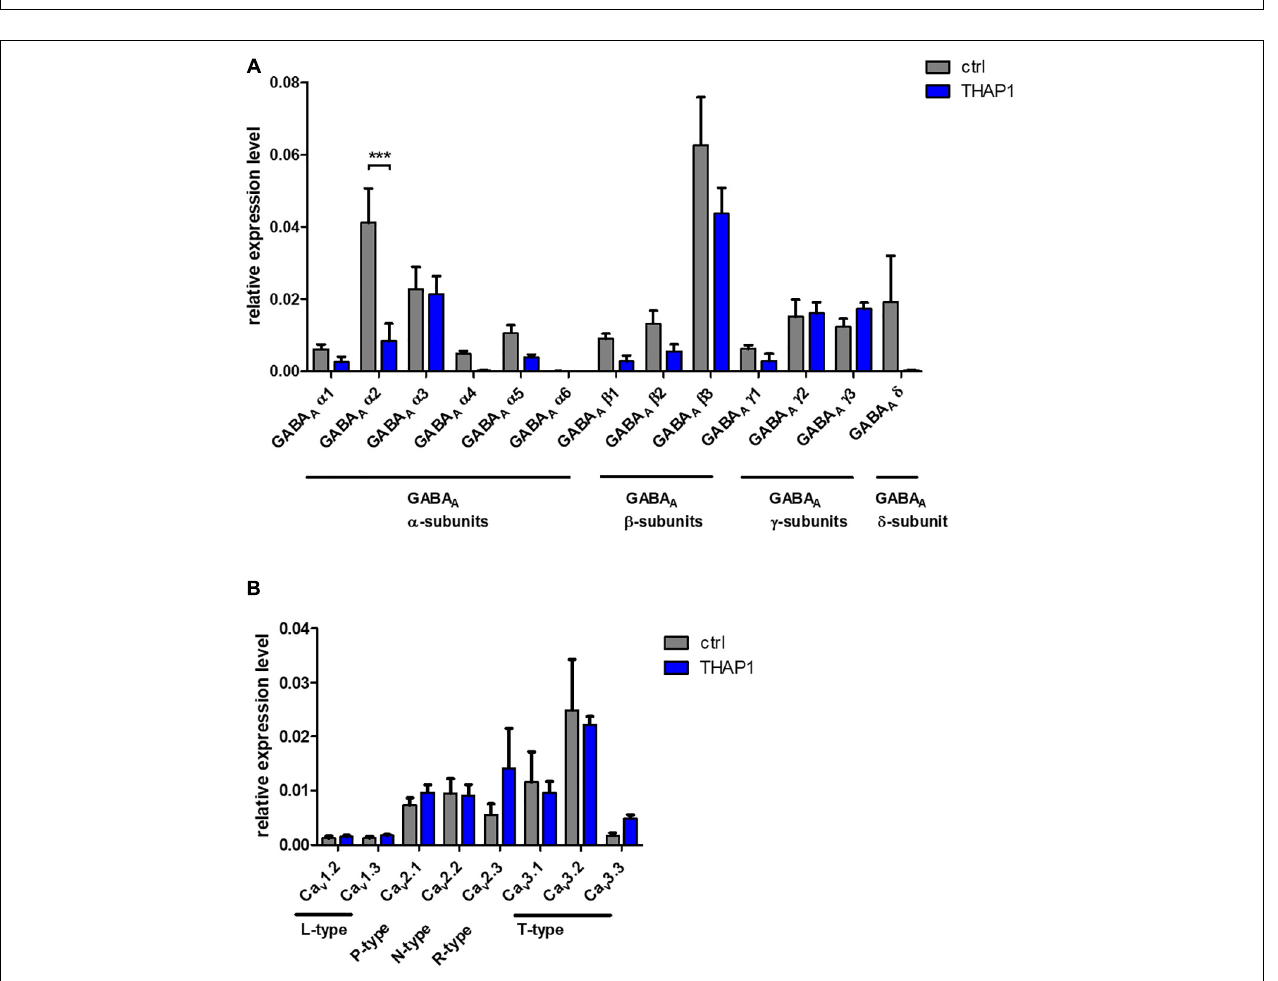
FIGURE 4 | Expression analysis of ion channels in MSNs from DYT-THAP1 patients and healthy controls by quantitative real-time PCR. (A) Genomic expression of γ -aminobutyric acid type A (GABA A ) receptor subunits α (1–6), β (1–3), γ (1–3) and δ showed a significantly lower expression level of GABA A α 2 subunit in THAP1 compared with control MSNs. (B) Genomic expression of voltage-gated Ca 2 + -channels was similar in THAP1 and control MSNs. Data are presented as means ± SEM from three independent differentiations for each control and THAP1 line (*** p < 0.001, two-way ANOVA with Bonferroni post hoc